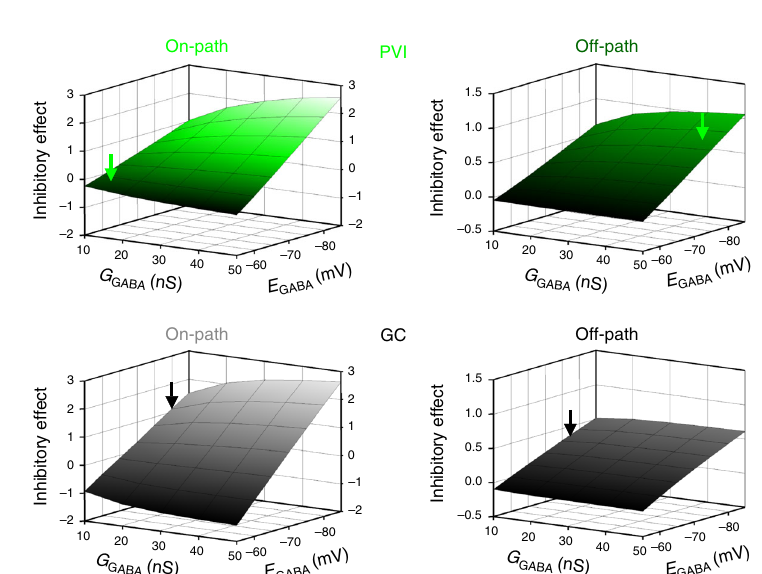
Fig. 6 E GABA and G GABA gradients support the differential effect of on- and off-path inhibition. a , b Representative morphologically detailed PVI (left) and GC (right) models with experimentally constrained E GABA gradients along the somato-dendritic axis (color scale represents E GABA ). EPSPs were evoked at apical dendrites at a distance of 150 µ m from the soma (5 nS, 5.1 ± 0.3 mV for PVIs, and 3 nS, 7.7 ± 0.6 mV for GCs, gray circles), while an inhibitory conductance was introduced at de fi ned locations along the same dendrite (50 µ m steps, red and blue circles represent G GABA sites at 50 and 250 µ m distance from the soma, respectively). Insets, superimposed representative traces of evoked EPSPs (gray), after induction of EPSPs with on- (red) or off- path inhibition (blue). c , d Inhibitory effect plotted as a function of distance from the stimulation site for PVI ( c ) and GC models ( d ) using different E GABA distributions (three PVI and three GC models). Black lines represent experimental data (from Fig. 1e), gray lines depict results using a linear experimentally constrained E GABA gradient, while blue, green and red traces represent models with uniform E GABA values. e Inhibitory effect plotted against G GABA and E µ m from soma) and off-path inhibition (right, 250 µ m from soma) for PVIs (upper panels, three model cells) and GCs (lower panels, GABA for on- (left, 50 four model cells). Arrows point to experimentally (in vitro) obtained E GABA and approximated G GABA values for on- and off-path inhibition (see Figs. 2,